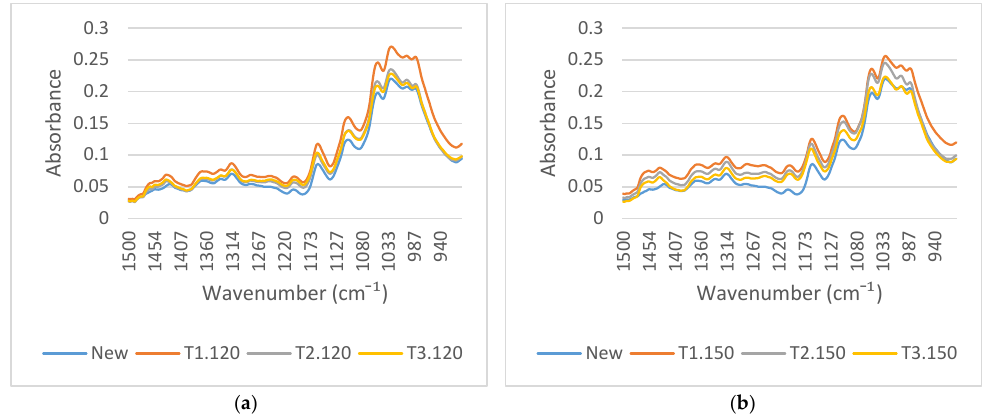
Figure 11. FTIR spectra at wavenumber 1500–900 cm − 1 of transformer insulation paper at aging temperature ( a ) 120 ◦ C and ( b ) 150 ◦